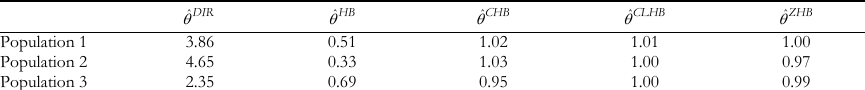
Overshrinkage correction as measured by the indicator * ˆ ( ) AV  ,